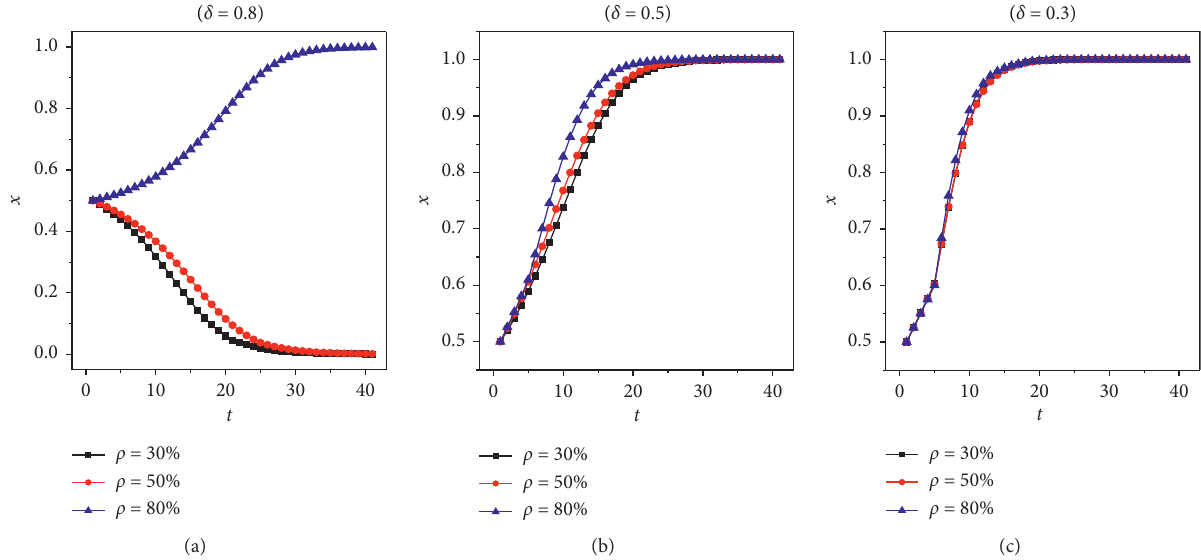
Figure 7: The proportion of innovation-leading firms in the group for different patent fee intensity ρ on three levels of the innovation risk δ based on the improved game model.